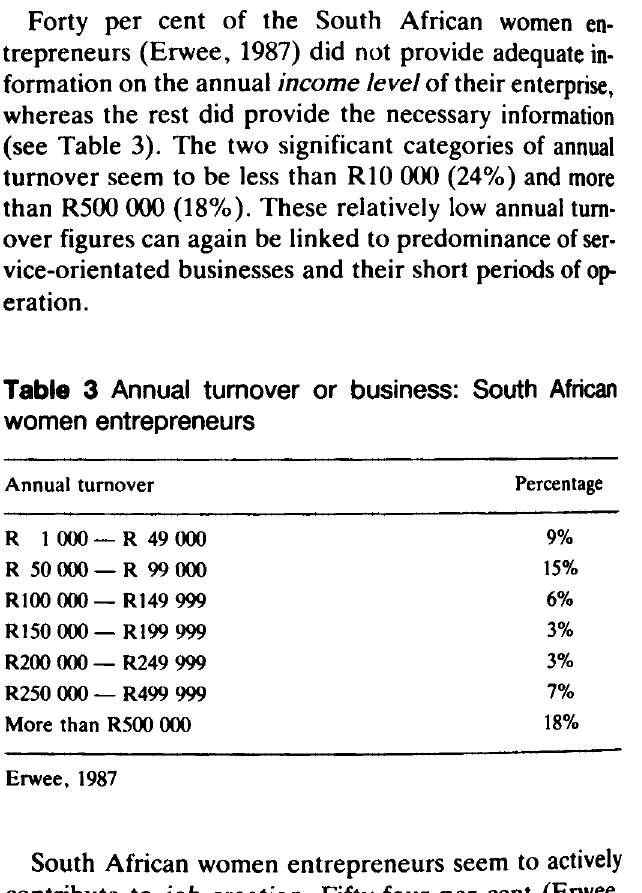
Table 2 Type of business: South African women en trepreneurs (n = 160)